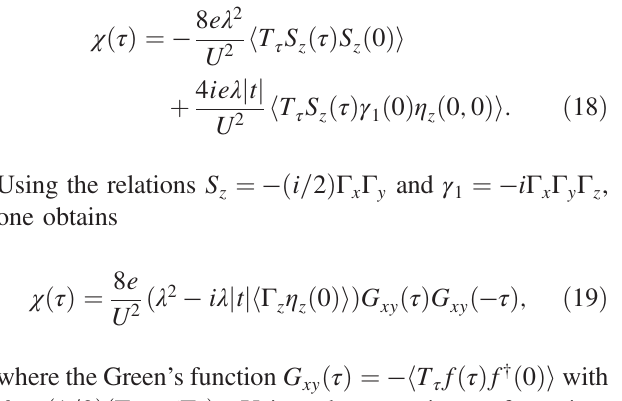
FIG. 4. Impurity-spin susceptibility for a system of L ¼ 64 sites with U ¼ 8 and t ¼ 1 , where different dashed lines correspond to simulations where we have multiplied the Kondo term of Eq. (4) by K ¼ 0 , 0.5, 1, 1.5, 2 (from top to bottom). The blue line (round points) thus represents the unmodified Hamiltonian (4). The solid lines show a fit to a log ð b λ 2 Þ [see Eq. (20)], with a and b as fit parameters over a regime of intermediate λ . The dotted yellow line is a comparison to results obtained in linear response for the case without Kondo